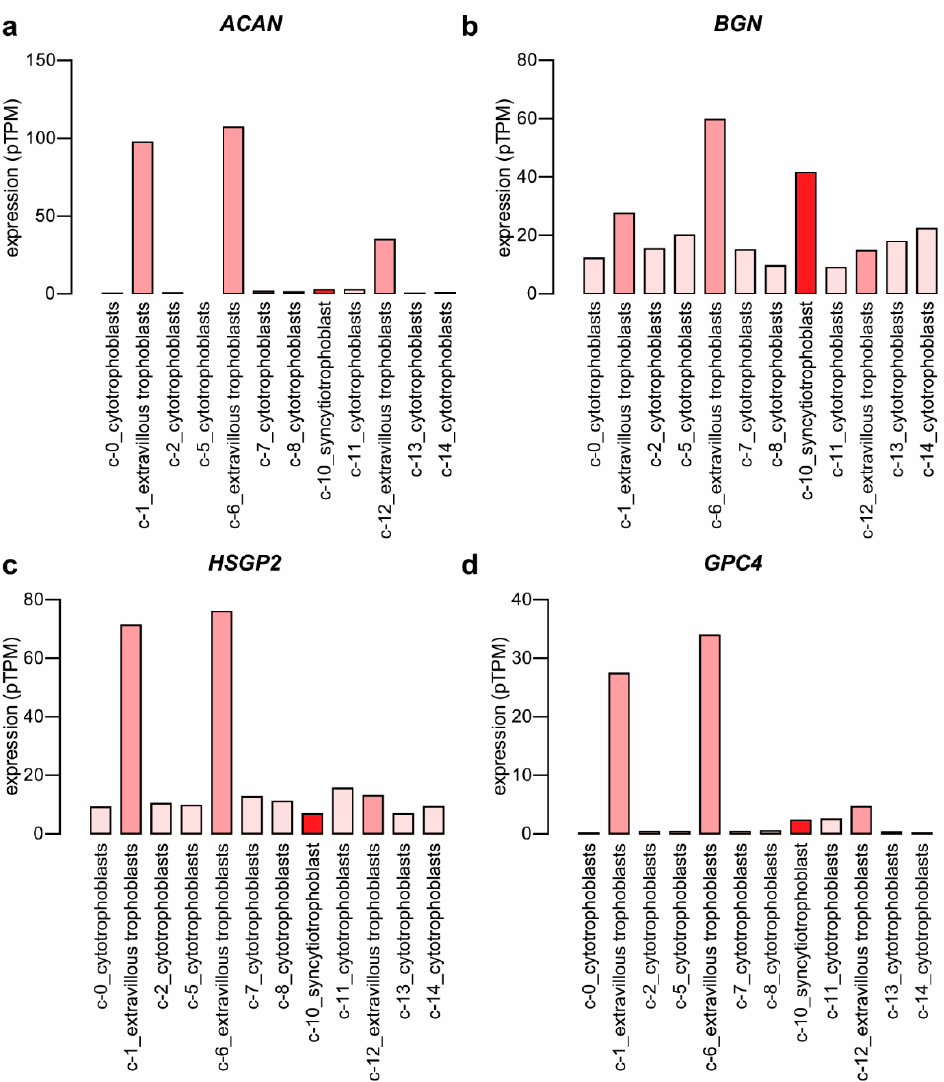
Figure 5. Expression of selected proteoglycan genes in the placenta. Single-cell RNA-seq data were downloaded from the Human Protein Atlas [56]. The original study was performed by Vento-Tormo et al. [55]. ACAN ( a ), BGN ( b ), HSPG2 ( c ), and GPC4 ( d ) mRNA expression (pTPM) in trophoblast cell clusters (colored with shades of red) were visualized on a bar chart. Protein-transcripts per million—pTPM.